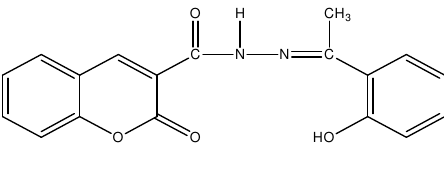
Figure 1. Structure of ligand, HL